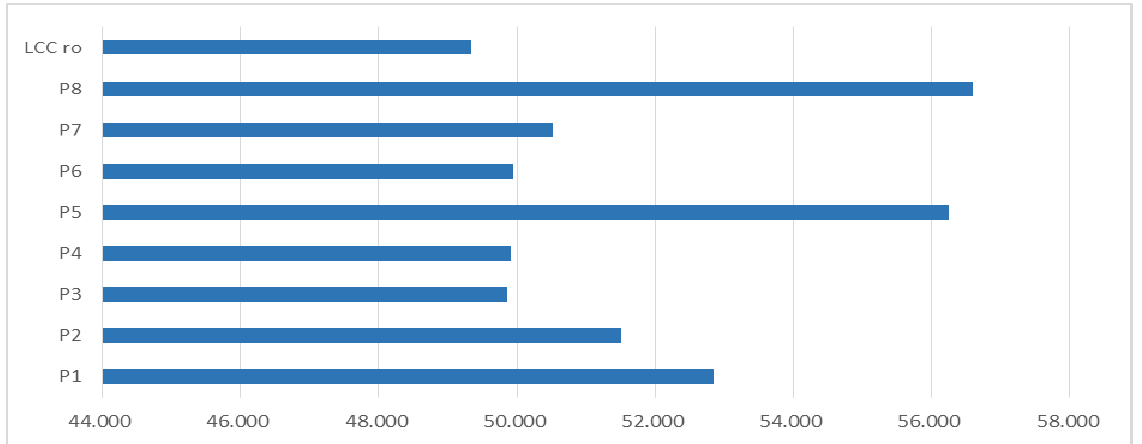
Figure 11. LCC at county level for the average scenario (bln.euro). Figures 12 and 13 (and also Appendix C, Table A3) presents LCC at regional level for each project in each county for the maximum scenario. And in the case of this scenario in most counties in the